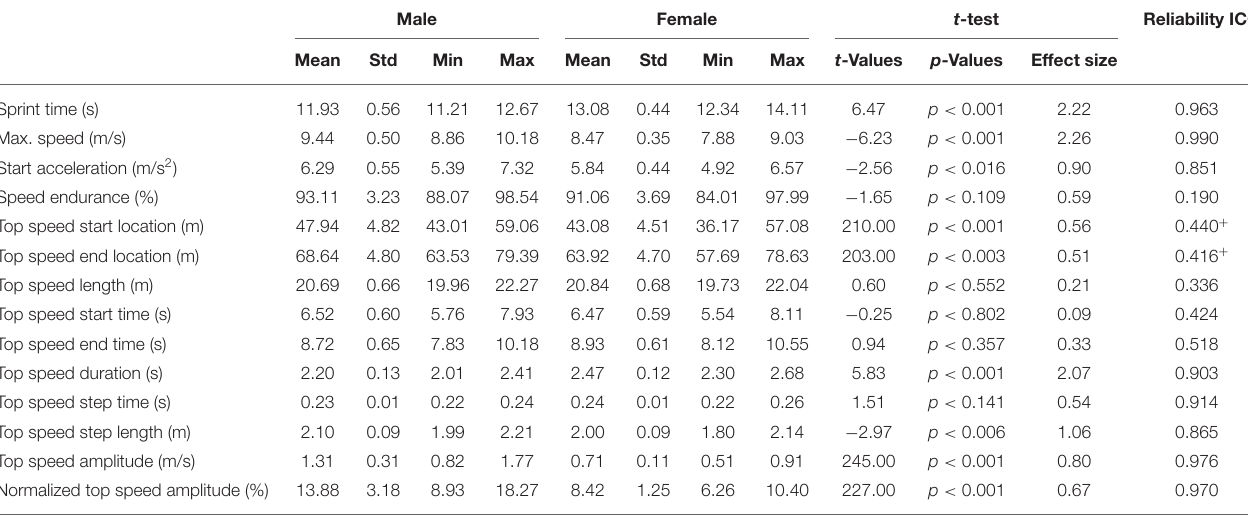
Sprint time was measured by the RedFIR system. Maximum speed, maximum acceleration and speed endurance are obtained by v base ( t ) whereas amplitude, step length and step time are obtained by v base ( t ) . Results of t-tests/Mann-Whitney (t-value, p-value and effect size d). + Mann Whitney